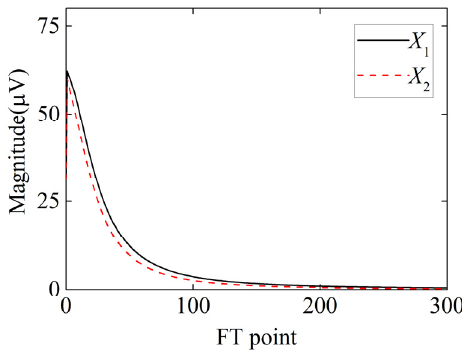
Figure 6. The frequency domain waveform of simulated PD pulse for the defect at d = 250 m.